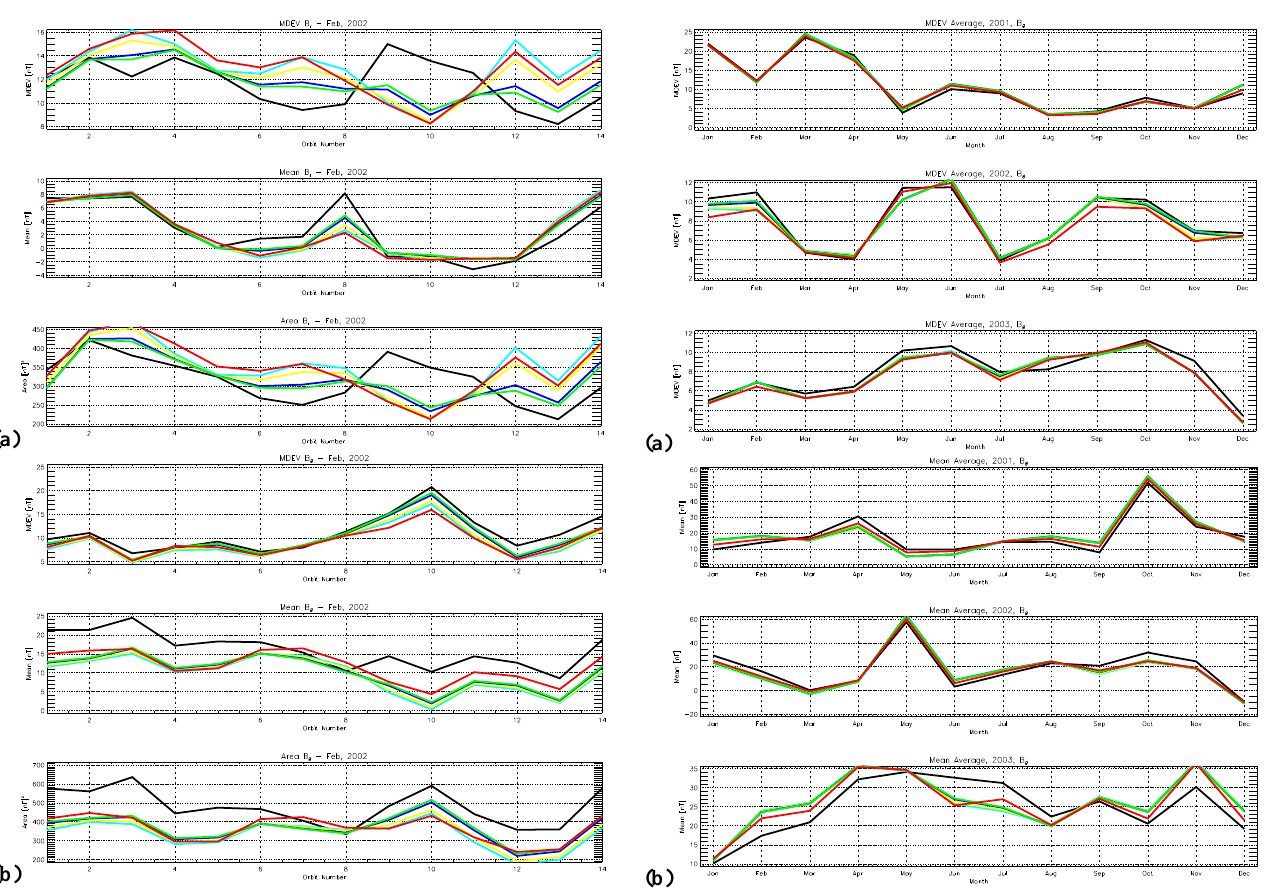
Fig. 5. Statistics of the dayside orbit passes for 14 February 2002: MDEV (top), MEAN (middle), and Area (bottom) vs. orbit number. The CHAMP/CHAOS/TIE-GCM (a) B r and (b) B θ residuals as in Fig. 4 are shown vs. the orbit number. All five TIE-GCM model runs (GPI (red), F 10 . 7 = 70 (green), F 10 . 7 = 90 (blue), F 10 . 7 = 150 (yellow), F 10 . 7 = 190 (cyan)) and the CHAMP residuals (black) are displayed.